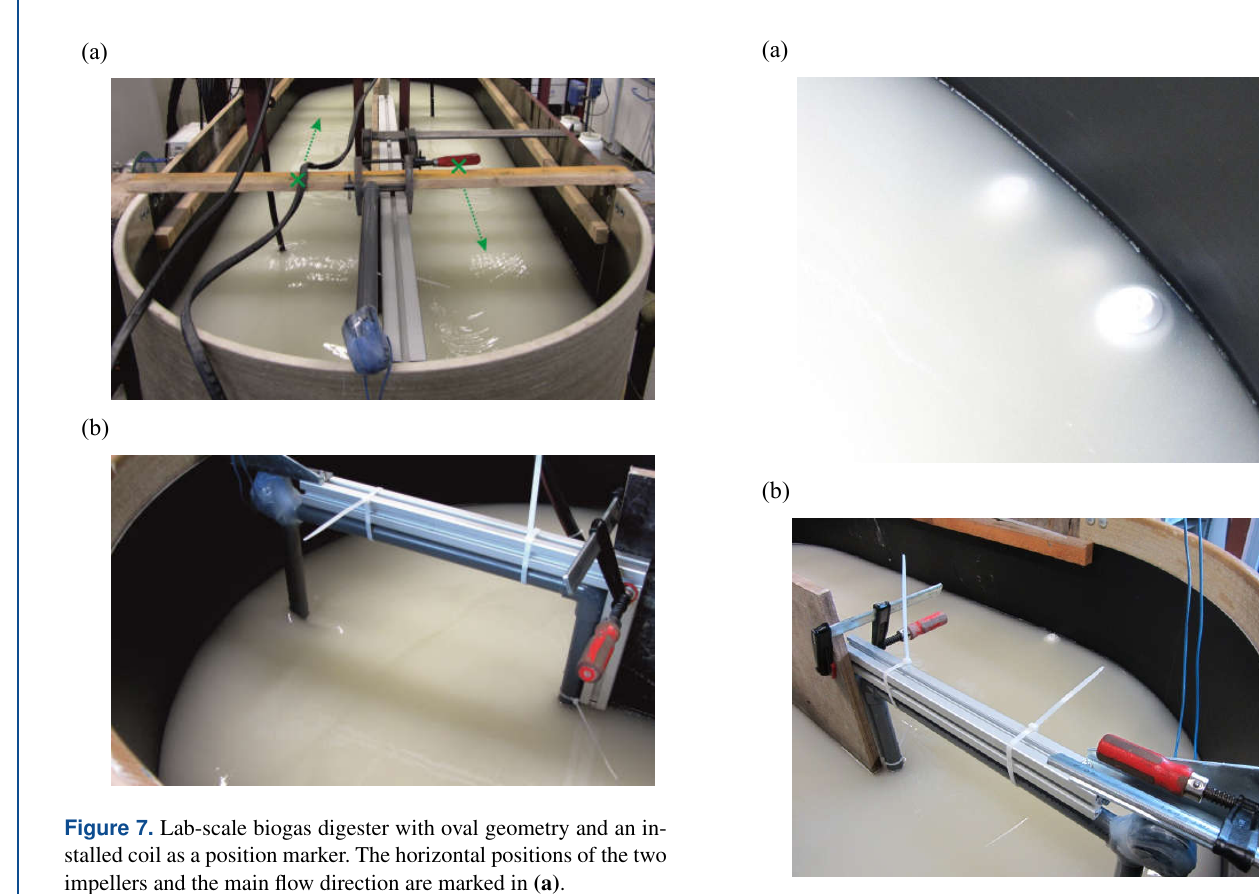
digester without position marker, and the threshold value was minimized. Finally, the temporal differences in the binary signal represent the horizontal circulation times of the sen- sor particles in the